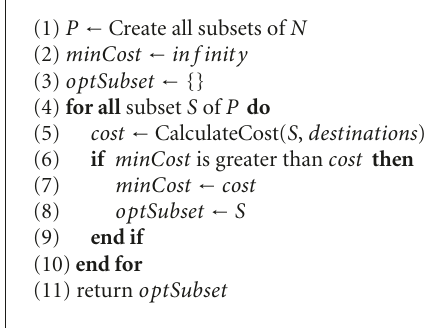
Algorithm 2: Finding Next Nodes for Destinations in PBM.